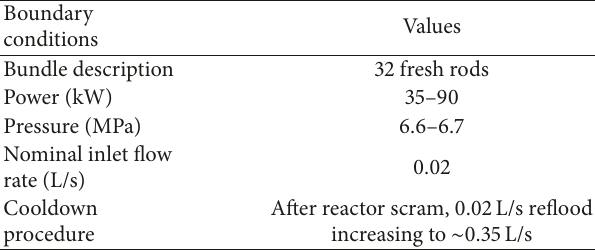
Figure 3: Two phases of the experiment, high temperature transient and reflood phase, in view of the bundle power-time profile. Table 1: Examples of boundary conditions used in the input code.